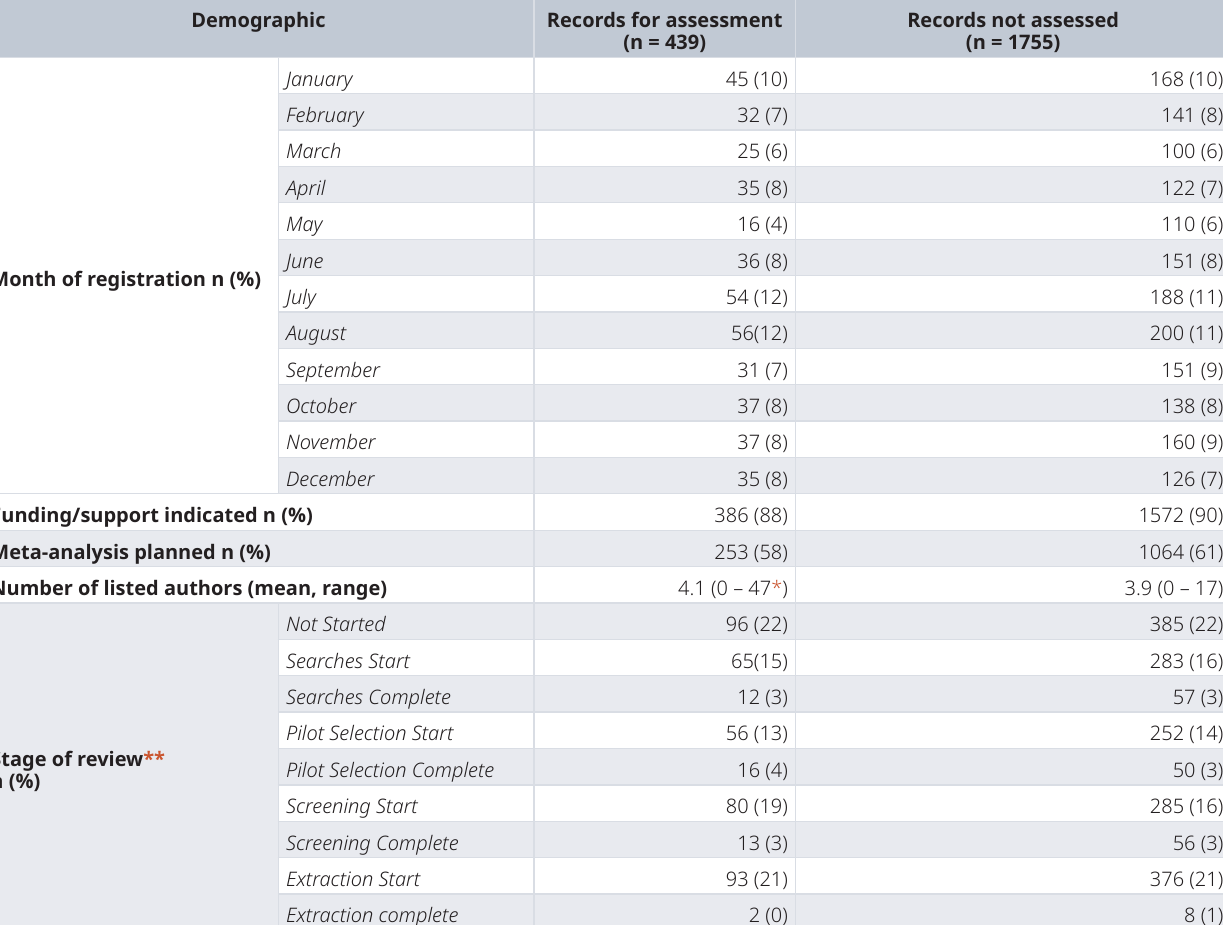
Table 1. Demographic details of non-sample set and sample set of the eligible 2018 PROSPERO